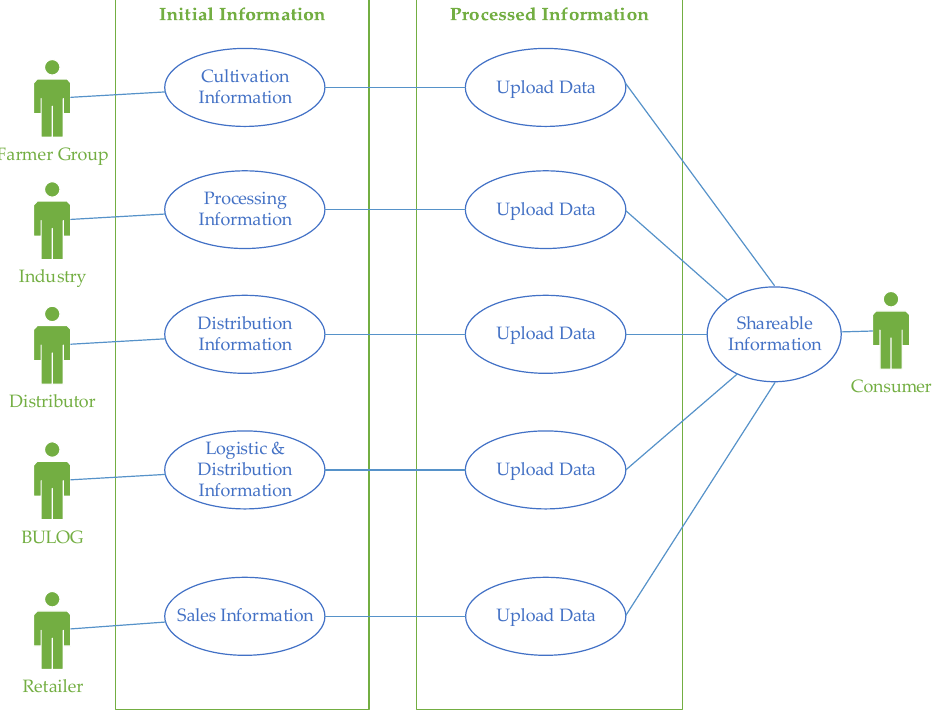
Figure 2. Use‐case diagram of a rice traceability system. Figure 2. Use-case diagram of a rice traceability